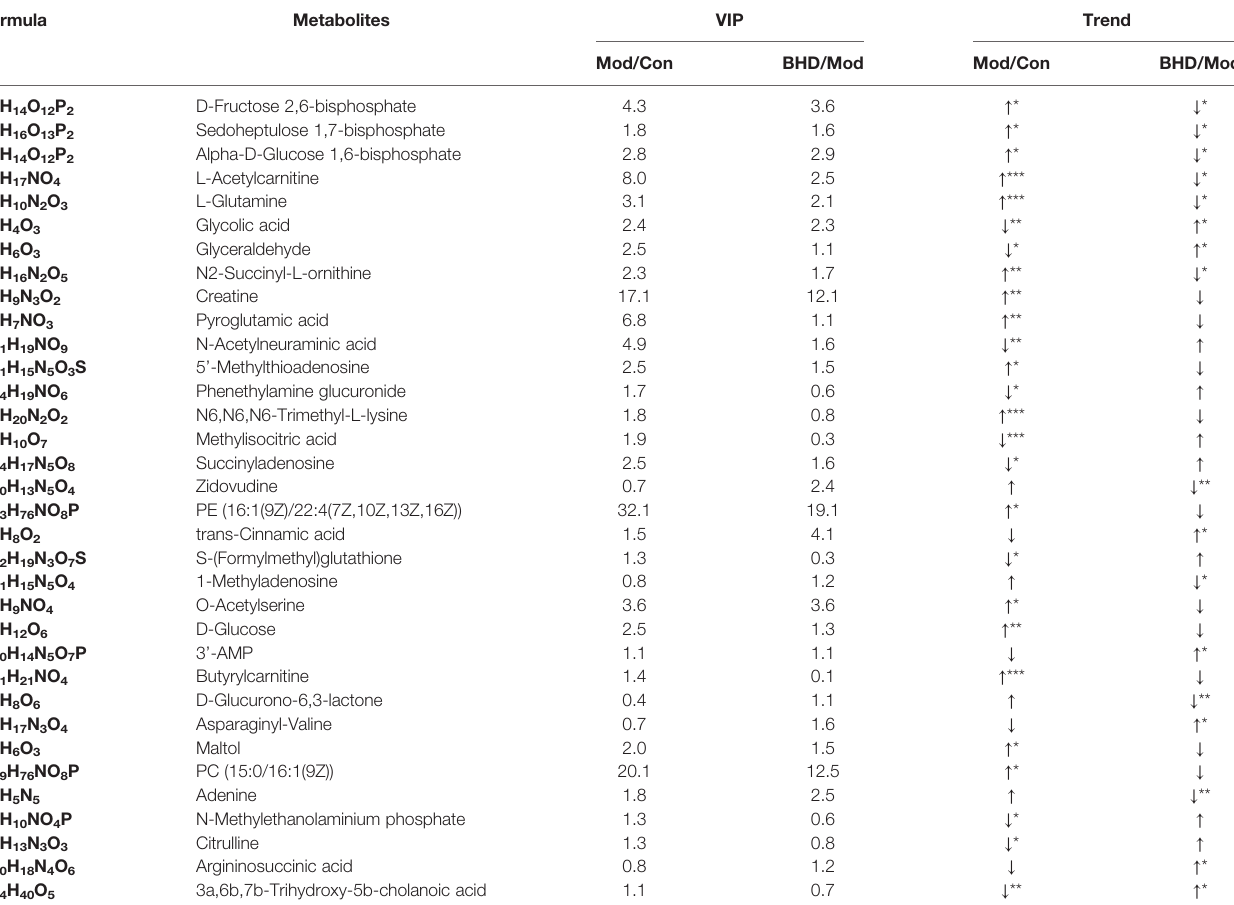
TABLE 1 | The differential metabolites in the hippocampus after BHD treatment.